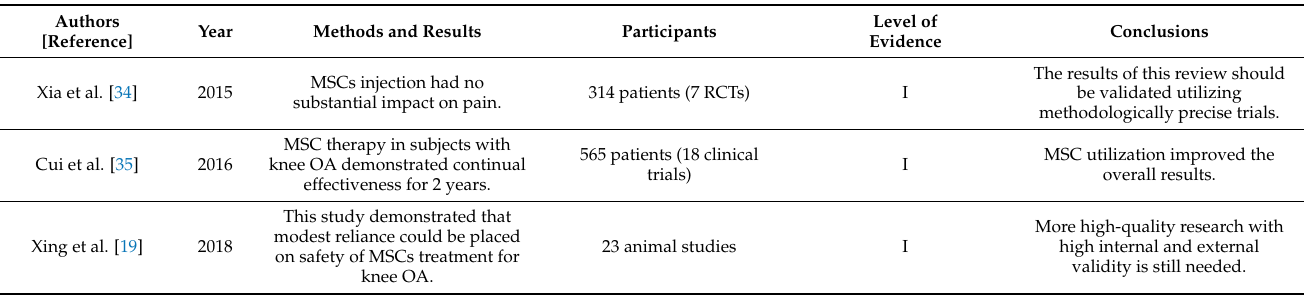
Table 1. Systematic reviews and meta-analyses on the effectiveness of intraarticular injections of MSCs in OA of the knee